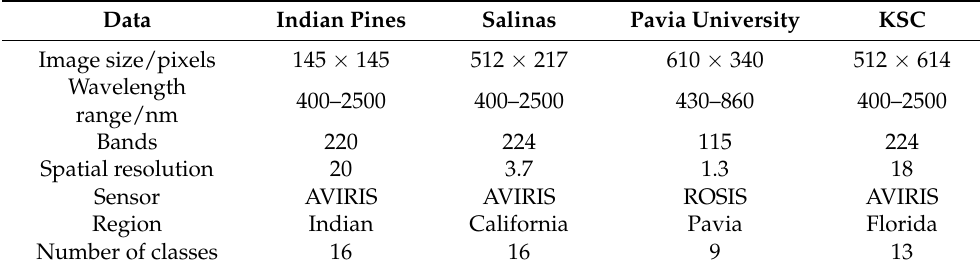
Table 1. Public hyperspectral data set and its